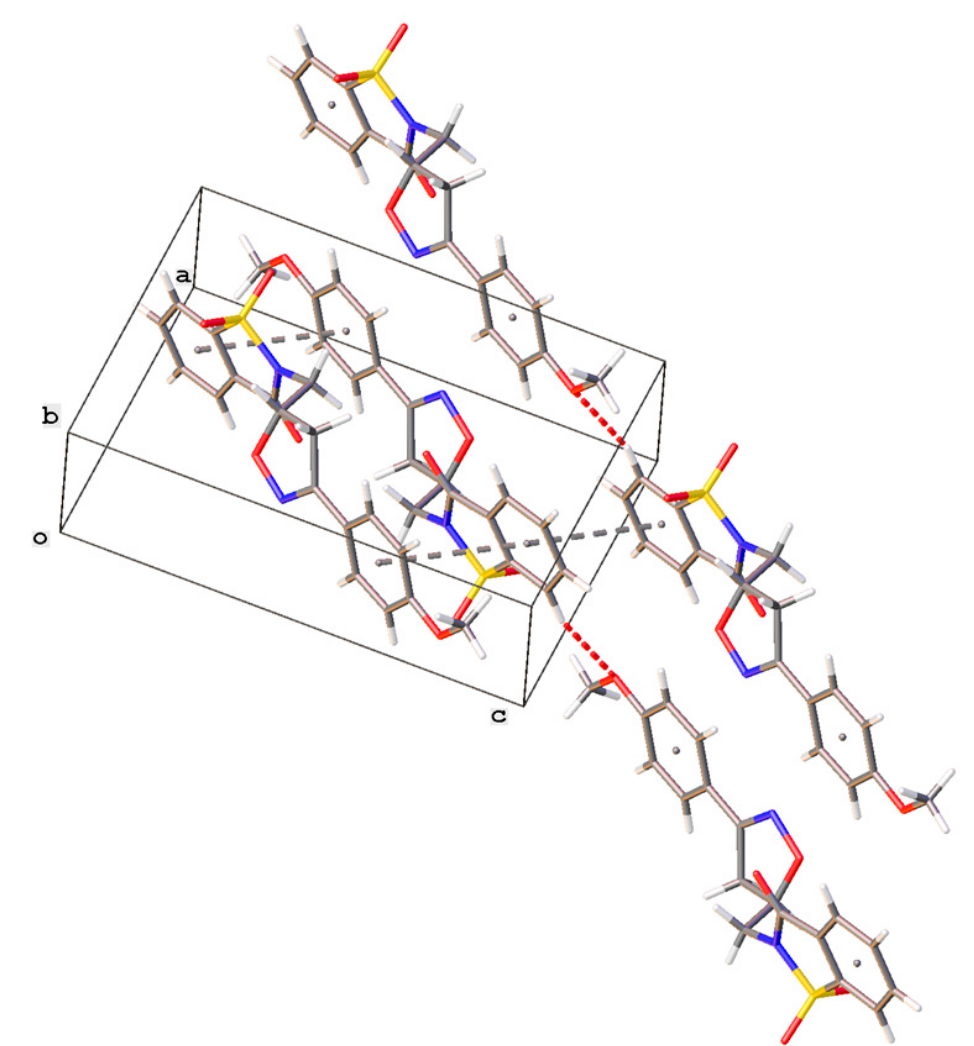
Figure 3. Partial crystal packing of N -(3-(4-methoxyphenyl)isoxazolin-5-yl)methylsaccharin show- ing C–H…O (red dashed lines) and π … π interactions (gray dashed lines). C–H . . . O (red dashed lines) and π . . . π interactions (gray dashed